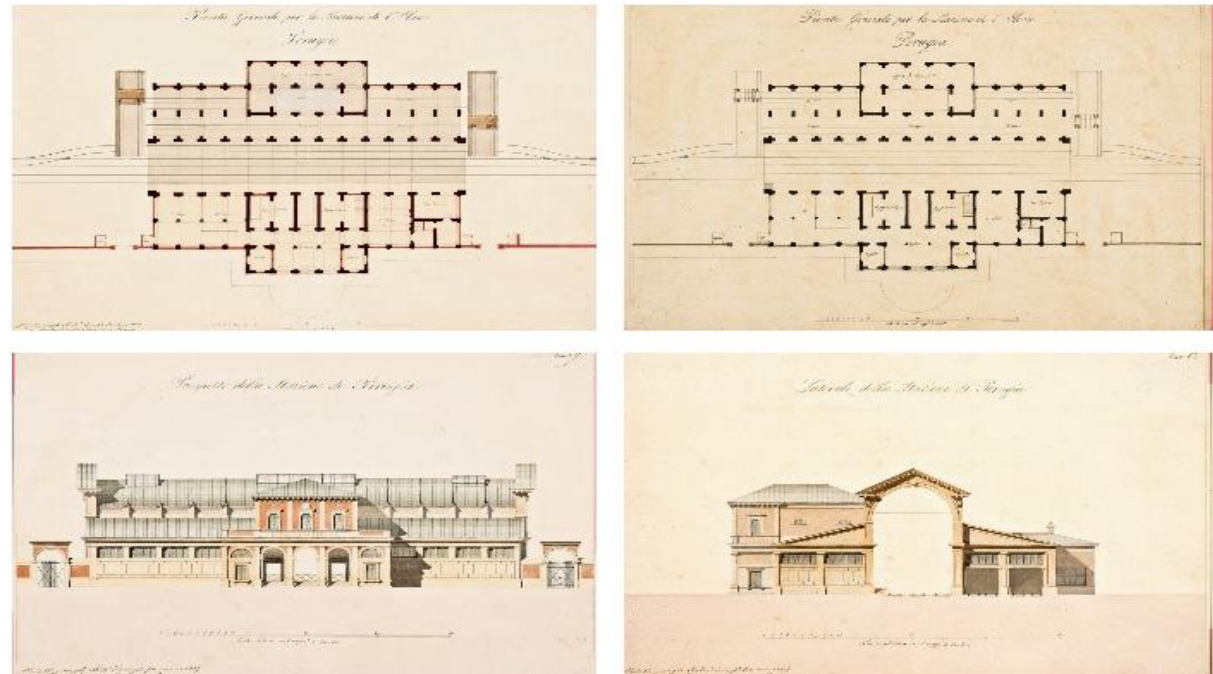
Figure 5. Project tables of first designed hypothesis of the station of Perugia Fontivegge, by the architect Antonio Cipolla. (drawings 3056, 3057, 3058 and 3059, Accademia di San Luca,